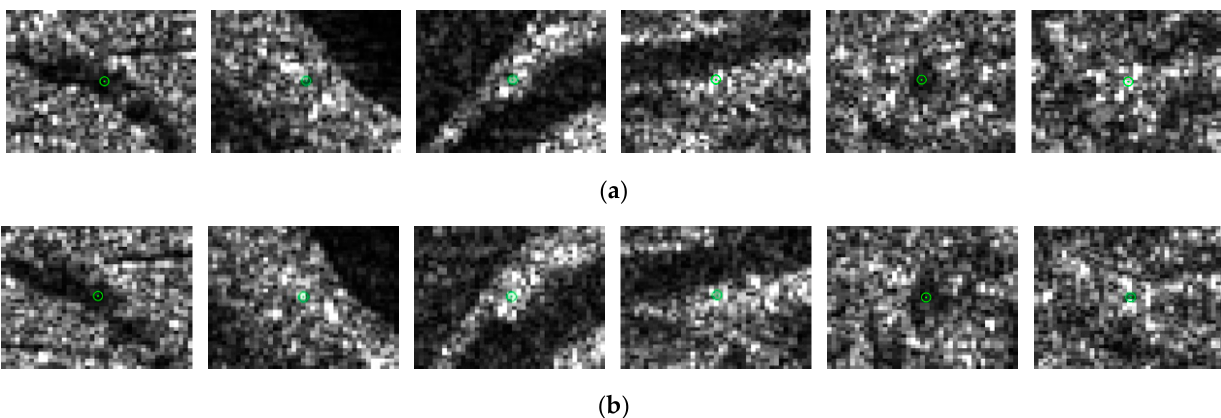
Figure 12. Location of tie-points in the adjacent SAR images between strips, where ( a ) is the master image and ( b ) is the slave image. The horizontal axes represent the azimuth direction, and vertical axes represent the slant range direction.